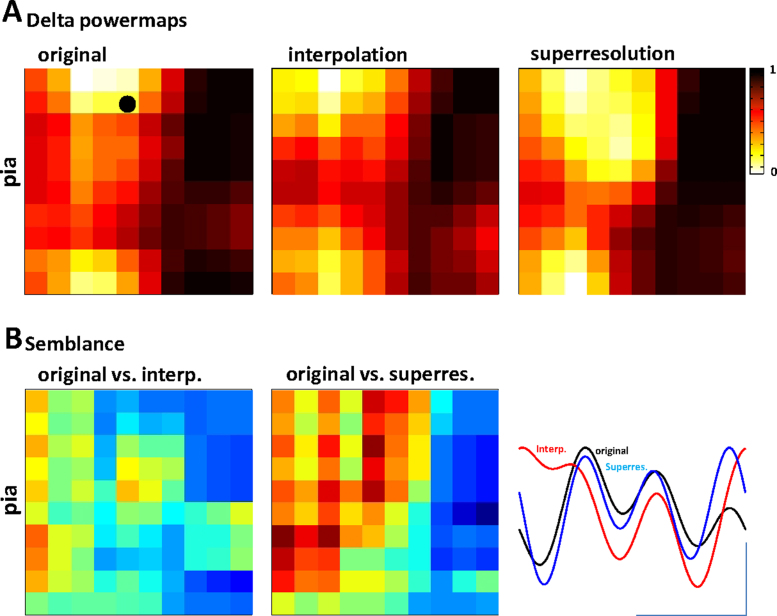
NEH superresolution is significantly superior to interpolation alone in reconstructing spatiotemporal properties of the delta rhythm. (A) Example powermaps of delta activity recorded with a 10 × 10 electrode array. Left panel shows delta power (0.5–2 Hz) derived from the FFT of the original voltage recording. Middle panel shows the delta power derived from the NEH method after halving spatial resolution by taking data only from every other electrode and inserting virtual electrodes as in Fig. 1A. Right panel shows delta power derived from interpolation of data from every other electrode in the original dataset. B. Wavelet semblance (Grinsted et al., 2004; Cooper and Cowan, 2008) maps of the two methods and comparison of 3 periods of delta rhythm for the same electrode/reconstruction vs. the original data (black circle in A). The spatiotemporal accuracy of the NEH superresolution was significantly better than interpolation (P = 0.0108).